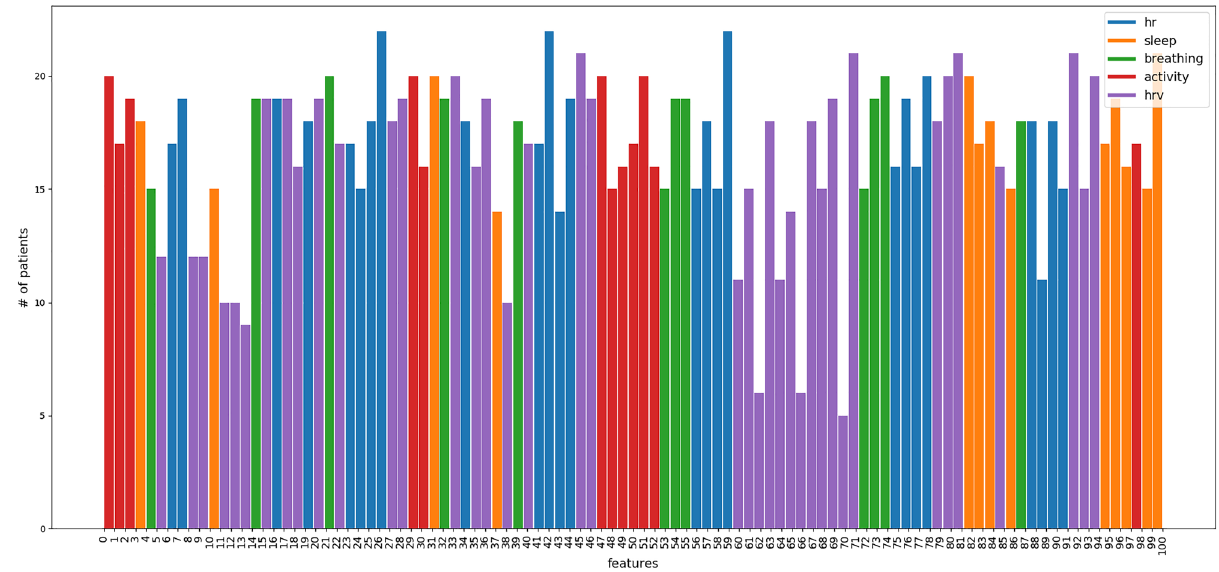
Figure 6. Histogram of features apparition in biosignatures. Histogram of unique features included in the biosignature of each patient. No feature was selected only for a single patient, and no feature was selected for all patients in the cohort. The colors represent the feature group to which the physiological variable belongs.